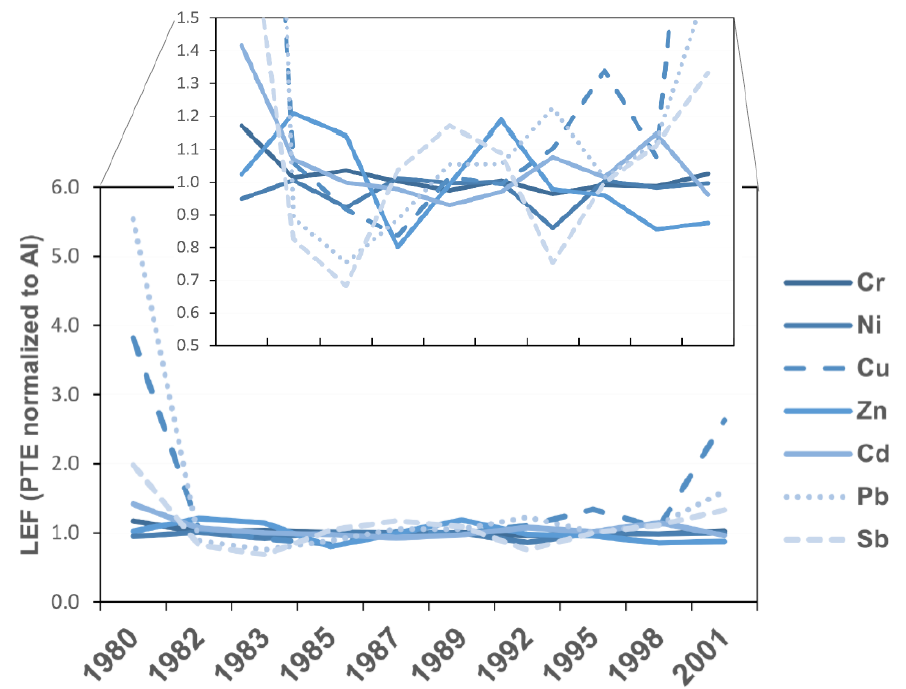
Figure 9. Local enrichment factors (LEFs) of potentially toxic elements relative to aluminum (Al) in samples of the Korana tufa. The upper diagram represents the enlarged lower diagram in the range of LEFs from 0.5 to 1.5 for better visibility. The elements are arranged following the periodic table groups.